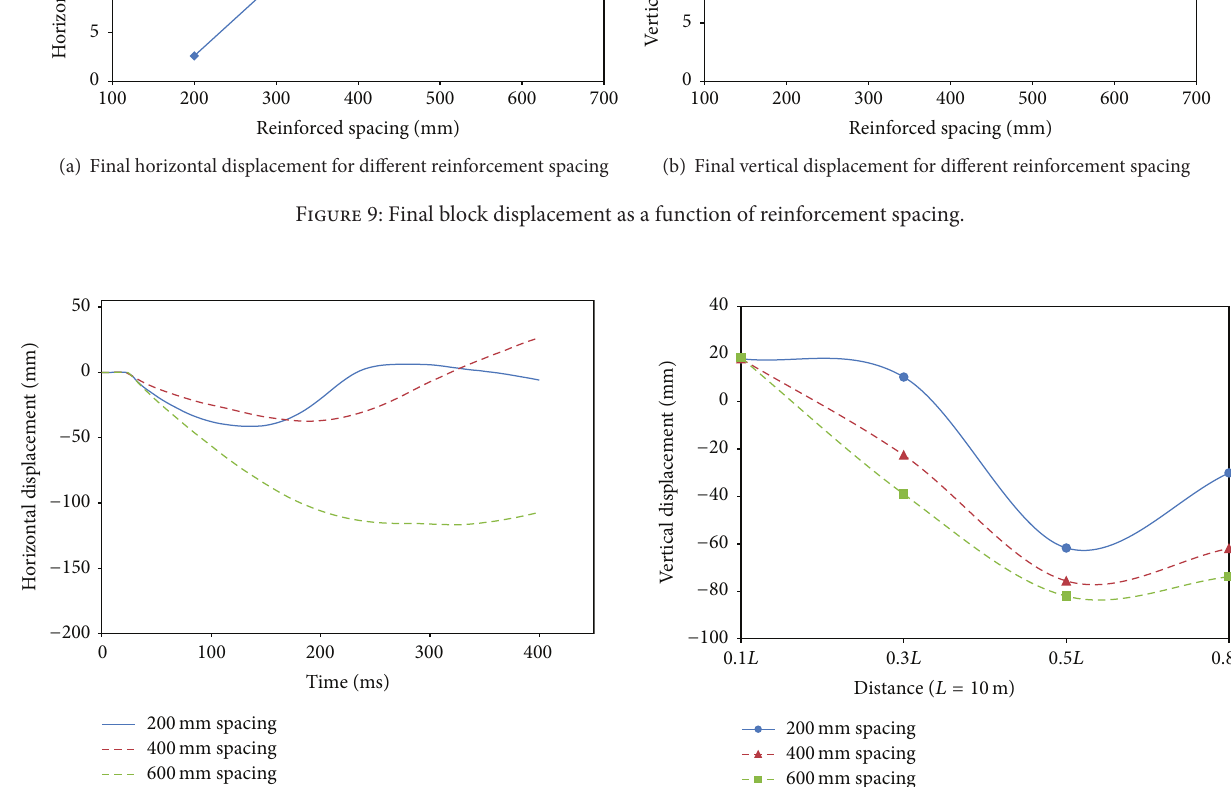
Figure 10: Block displacement at the top ( 𝐻 ) of reinforced retaining wall for reinforcement spacing.